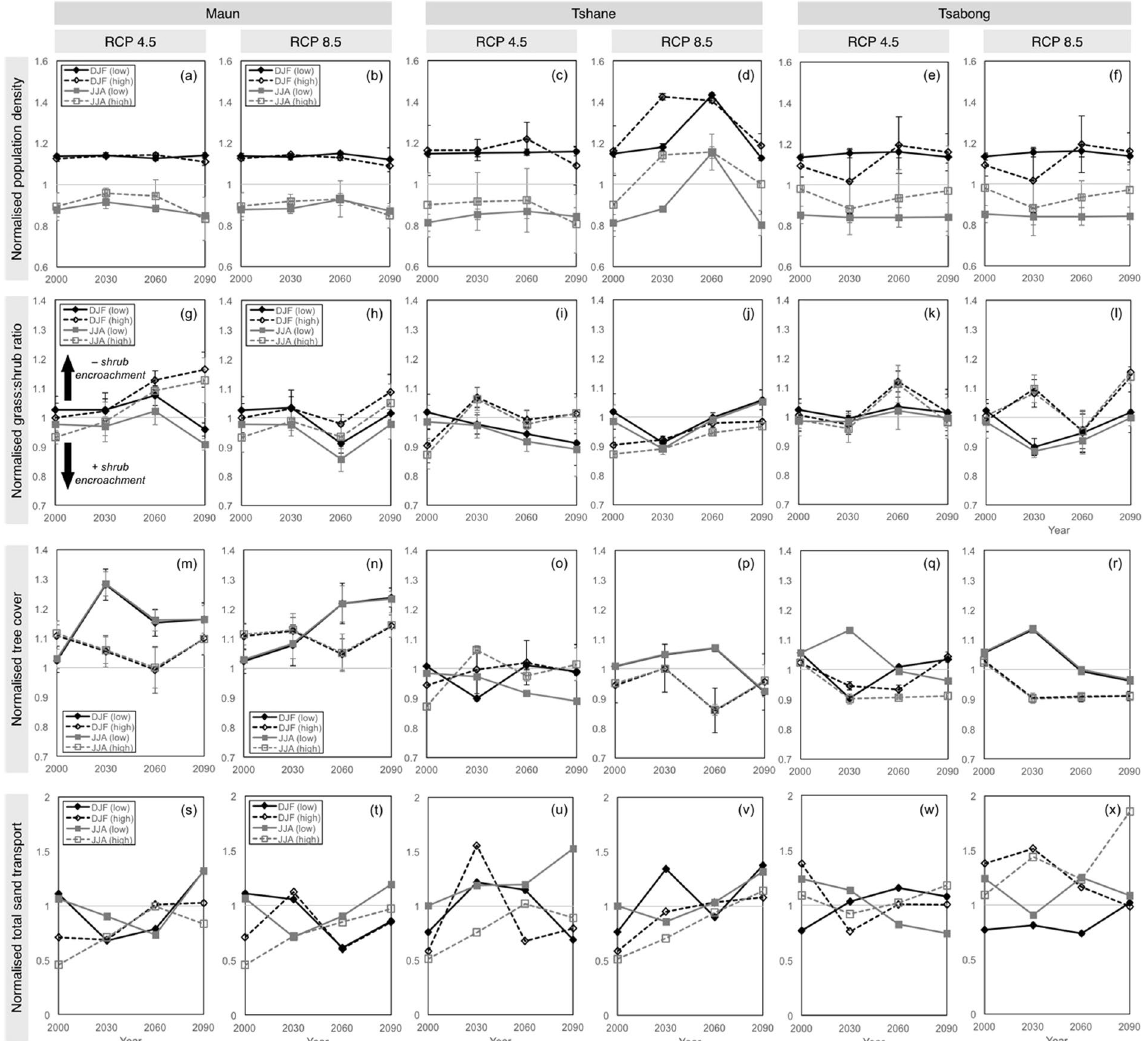
Figure 3. Equilibrium landscape characteristics at the three study sites for the three chosen years (2030, 2060 and 2090), separated by wet summer season (DJF) and dry winter season (JJA), and normalised to the annual average for the baseline year (2000, RCP 4.5). Results are shown for RCP 4.5 and RCP 8.5 scenarios, in low variability (standard deviation, σ = 30 mm annual equivalent) and high variability ( σ = 160 mm annual equivalent) precipitation conditions. Landscape characteristics: ( a – f ) normalised population density; ( g – l ) normalised grass:shrub ratio, where values above unity represent decreased shrub encroachment; ( m – r ) normalised tree cover; ( s – x ) normalised total sediment transport across the domain. Model was run to equilibrium for the equivalent of 200 model years, with 20 wind events every 3 months, over a grid of 150 × 150 cells. The domain was randomly initiated with 90% vegetation cover and random sediment depth. Landscape characteristics were calculated as means over the last 10 years of each run. Error bars show coefficients of variation where